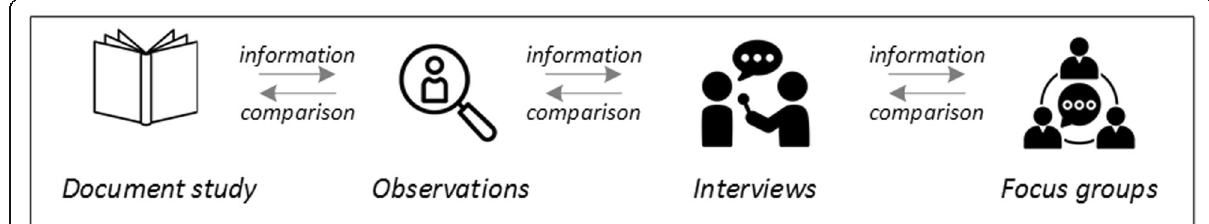
Fig. 2 Possible combination of data collection methods